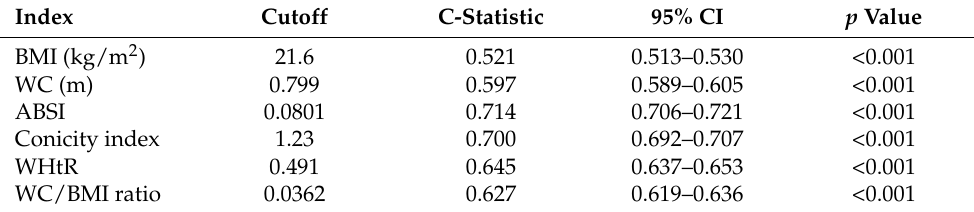
Table 3. Discriminatory power of body adiposity indices for high CAVI ( ≥ 9.0).